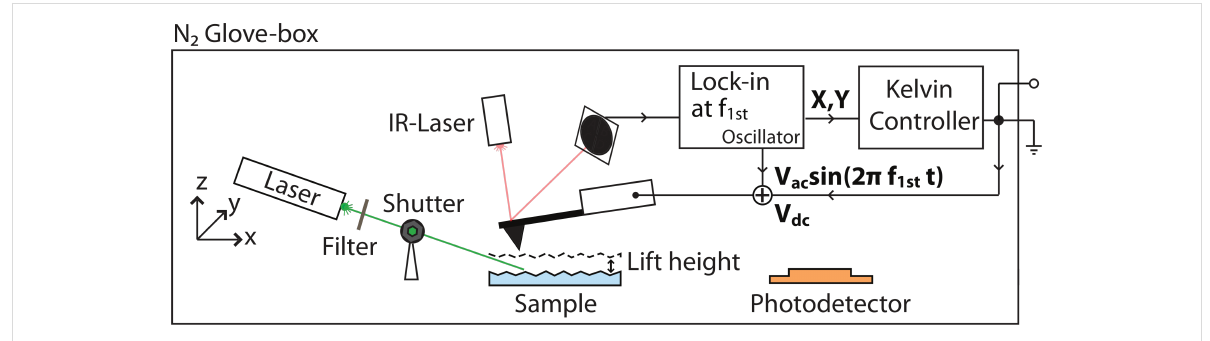
Figure 10: Lift-mode KPFM setup inside a nitrogen glove box in combination with a tunable illumination system for microscopic SPV measurements. The CPD was nullified by an applied dc voltage between tip and sample.